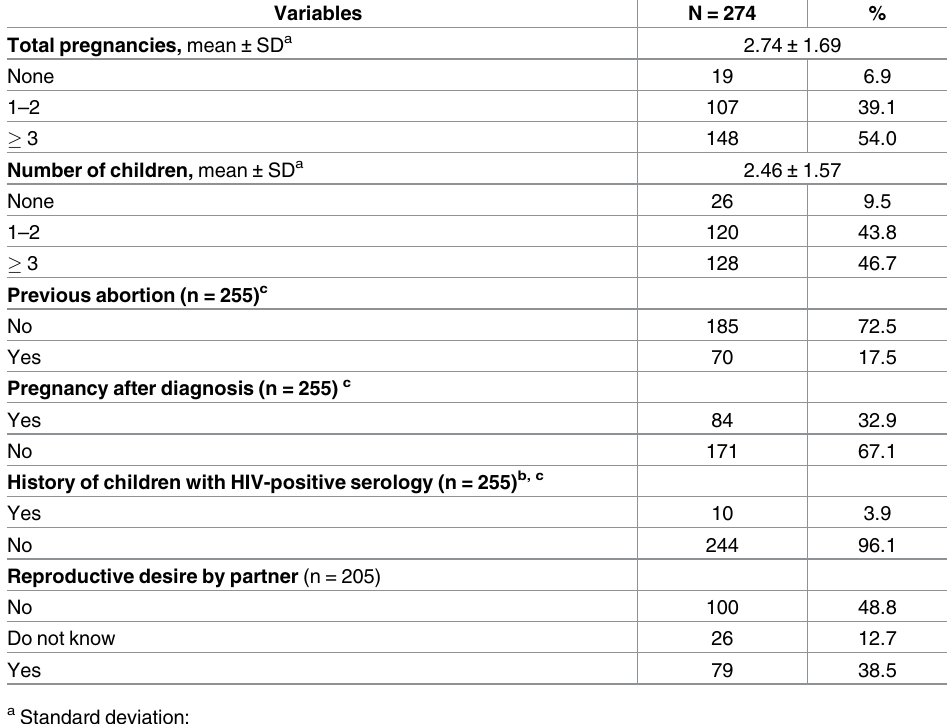
Table 3. Reproductive variables of WLWHA in Central Brazil, 2015–2016. Variables N =